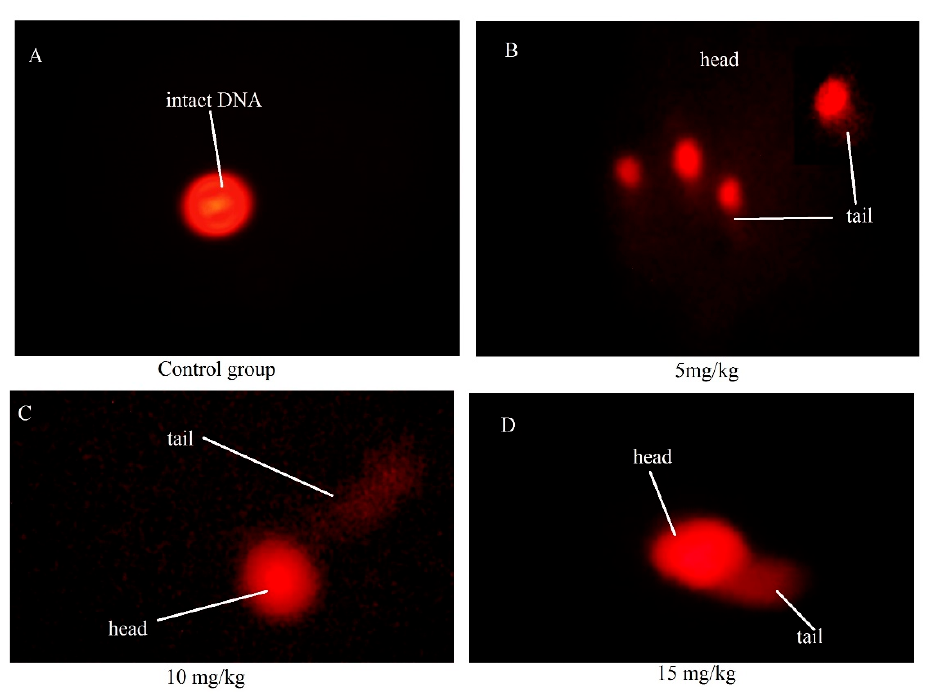
Figure 4. Fluorescent microphotograph of rat sperm after Cd treatment as determined by single- cell gel electrophoresis with acridine orange staining. ( A ) Control group presenting intact DNA, ( B ) 5 mg Cd/kg treatment, ( C ) 10 mg Cd/kg treatment, and ( D ) 15 mg Cd/kg treatment groups showing damaged DNA represented by the tail.